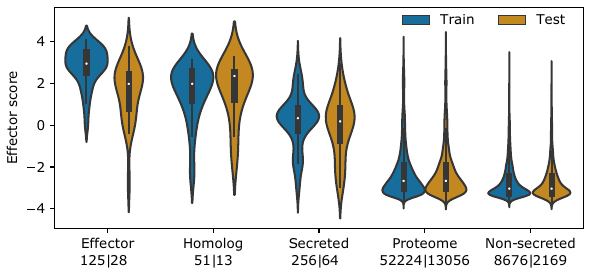
Figure 2. A violin plot showing the distributions of Predector effector ranking scores for each class in the test and training datasets. The effectors consist of experimentally validated fungal effector sequences. “Secreted” and “non-secreted” proteins are manually annotated proteins from the SwissProt database. Proteomes consist of the complete predicted proteomes from 10 well studied fungi (Supplementary Table S2). The number of proteins represented by each violin are indicated on the